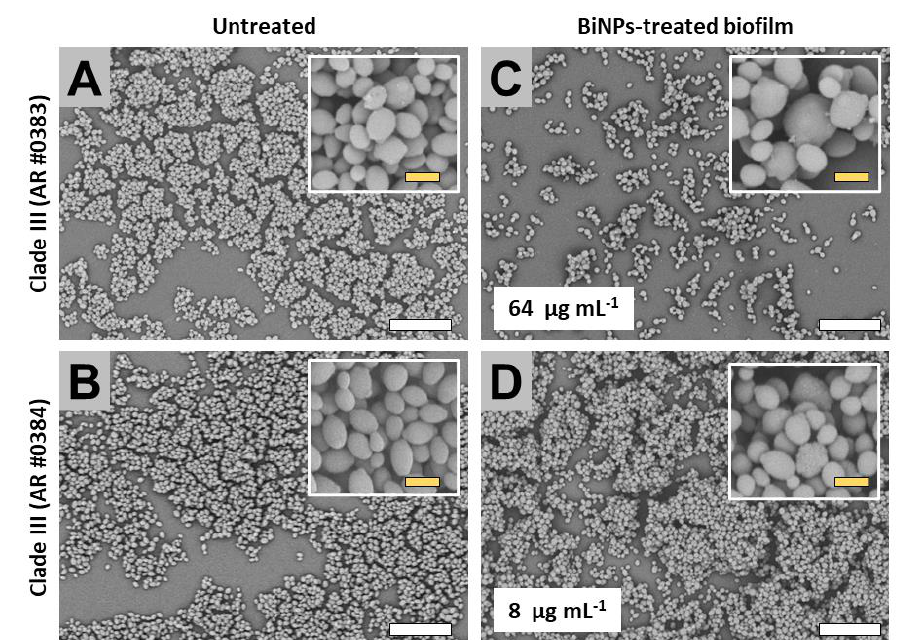
Figure 5. SEM observations on the BiNPs antibiofilm activity on the C. auris strains from the Clade III. The BiNP-treated strain displayed a reduced biofilm formation when compared to the untreated control no. 0383 ( A, C ), in contrast, the strain no. 0384 biofilms were not noticeably reduced ( B, D ). The cell morphology was affected by the BiNPs in both strains, no. 0383 ( A, C ) and no. 0384 ( B, D ). Scale bar: yellow 2 µm, white = 20 µm. Antibiotics 2020 , 9 , x